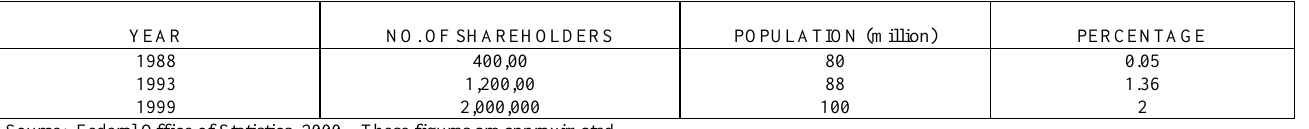
TABLE 5: SHAREHOLDERS STATISTICS